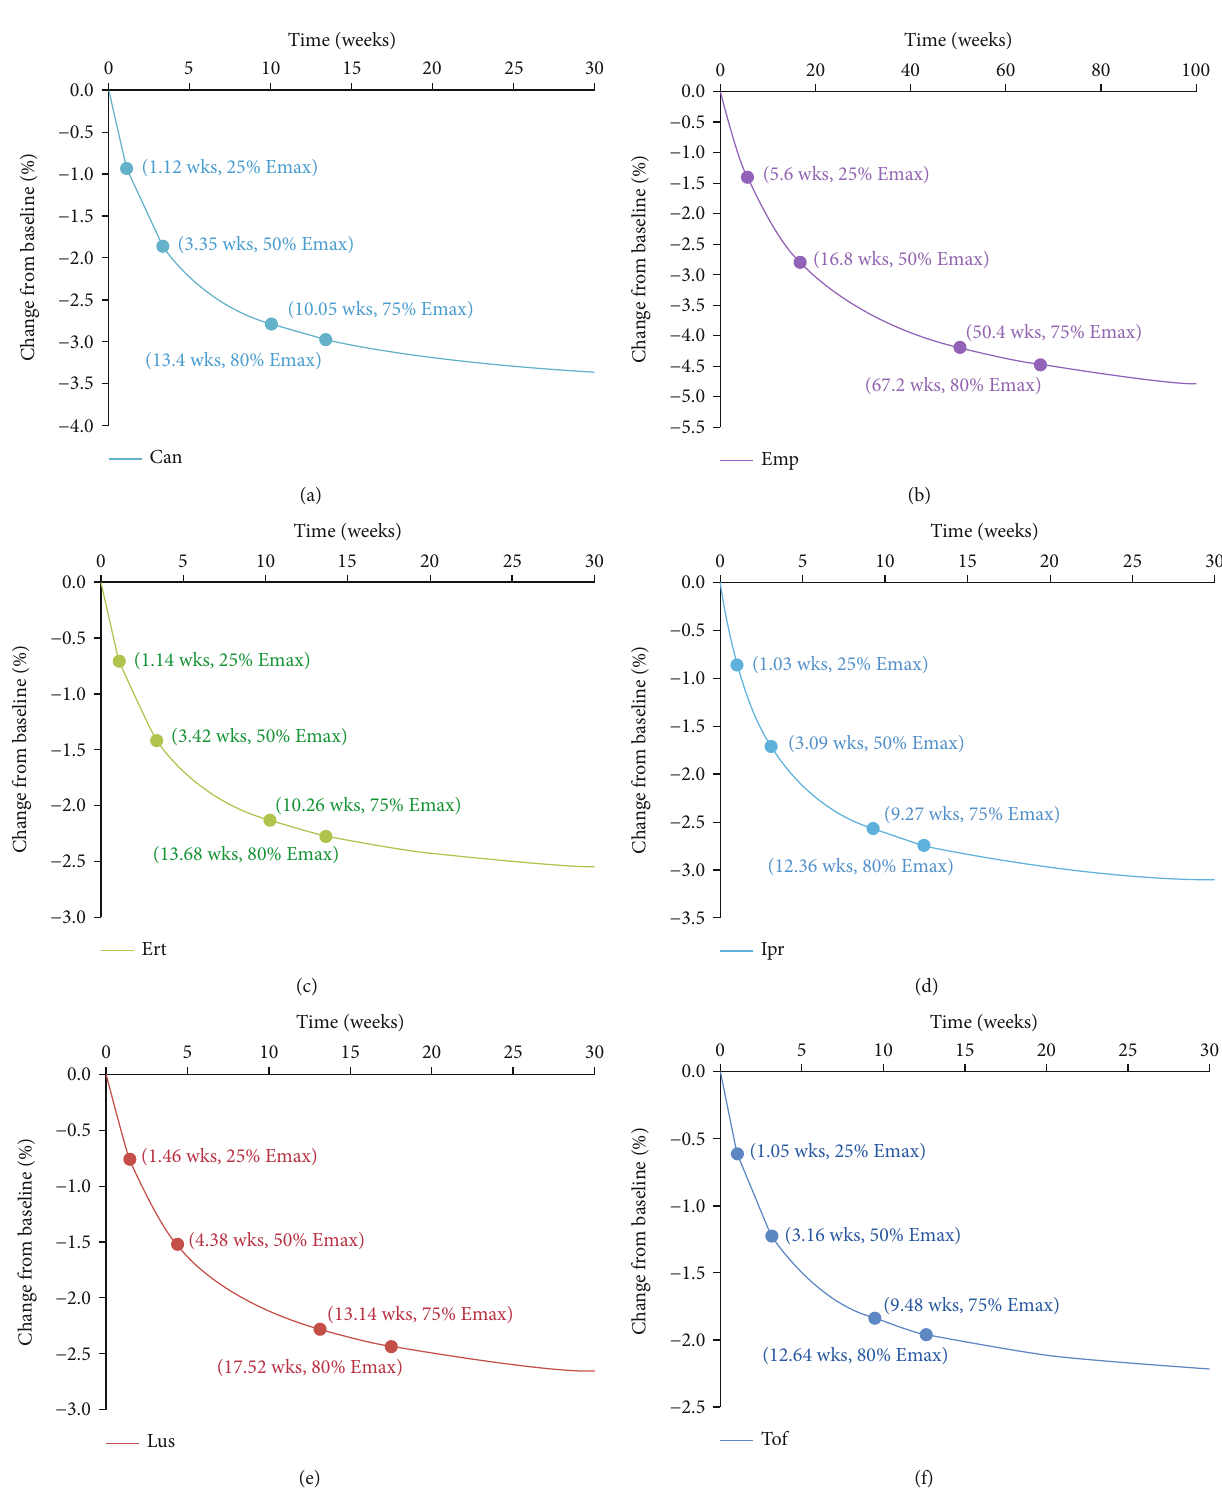
Figure 4: Model prediction: (a) canagli fl ozin, (b) empagli fl ozin, (c) ertugli fl ozin, (d) ipragli fl ozin, (e) luseogli fl ozin, and (f) tofogli fl ozin. wk: